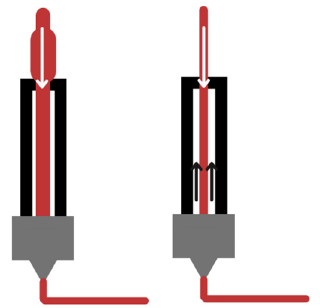
Figure 16. Filament